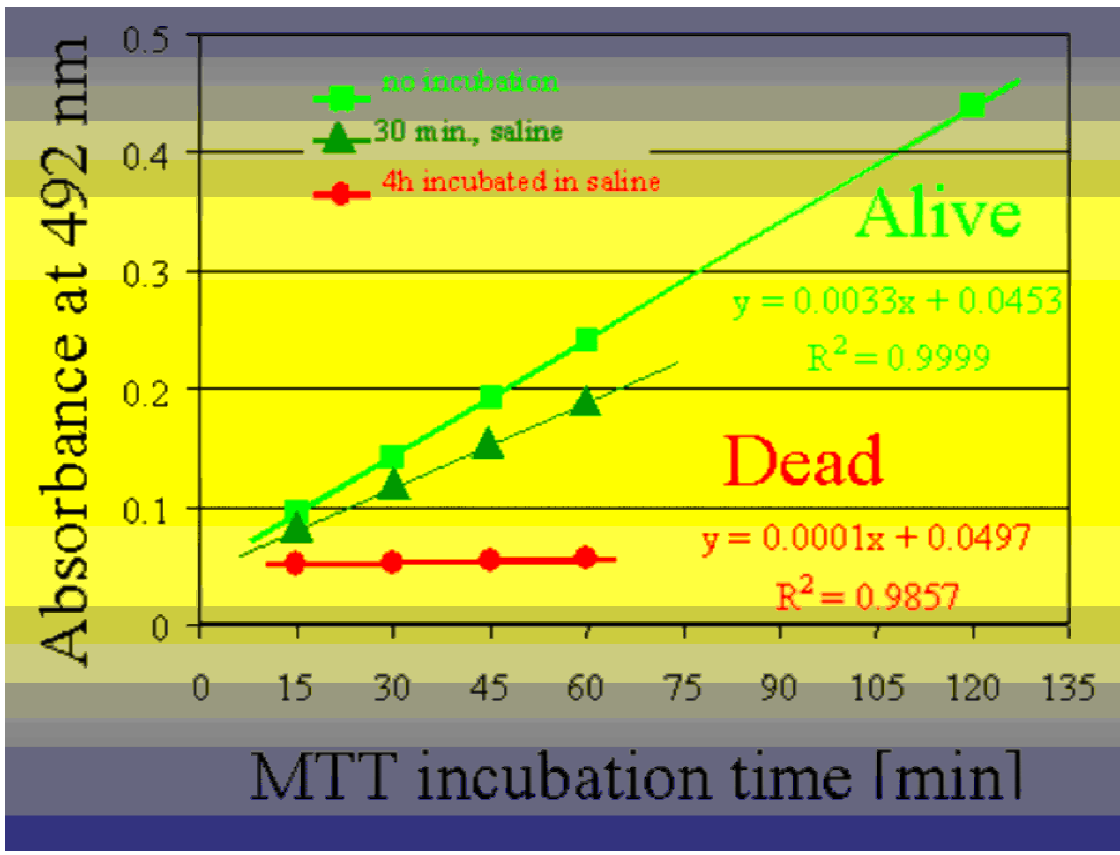
Fig. 3 Calibration curve for MTT assay on Caco-2 cells. Cells were washed of medium,